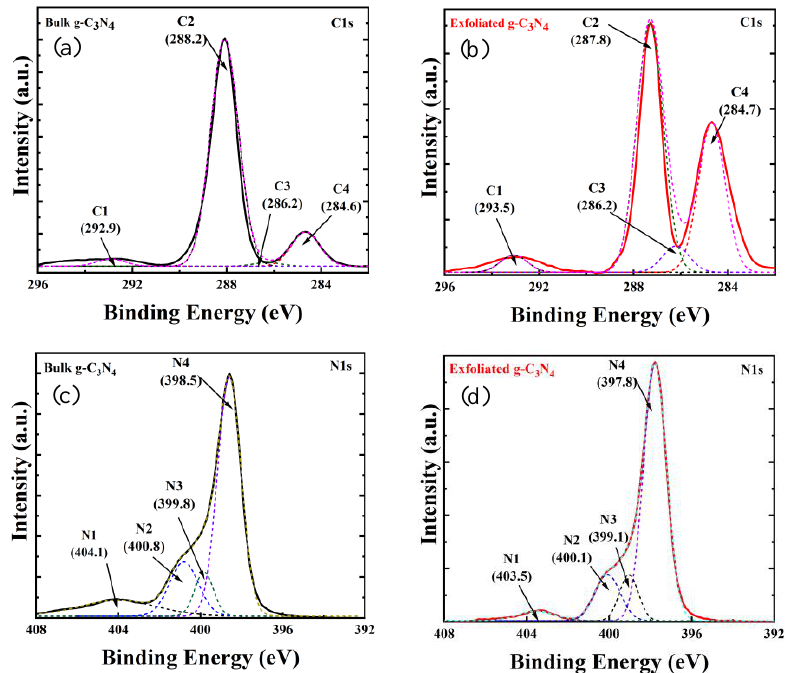
Figure 4. X-ray photoelectron spectra of bulk ( a , c ) and exfoliated ( b , d ) g-C 3 N 4 (C1s and N1s).